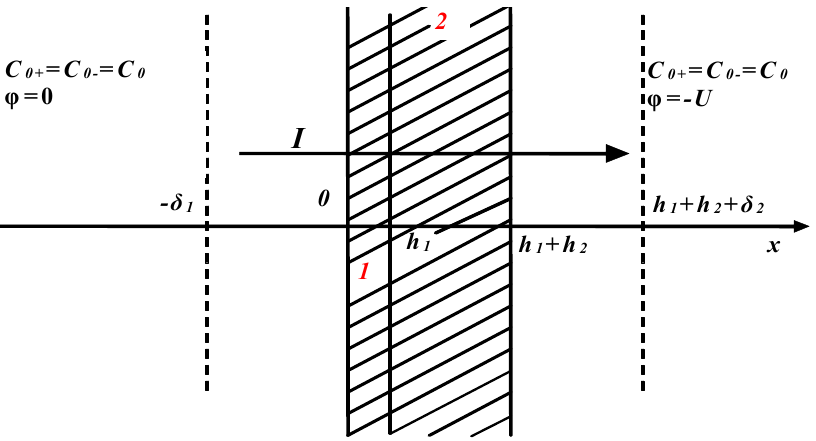
Figure 1. The scheme of electrodiffusion through bilayer membrane (s-orientation): 1-neutral layer; 2-charged layer; C 0 = C 0 ± —the equivalent concentration of 1:1 electrolyte in the intensively stirred areas of the cell; φ -electric potential.